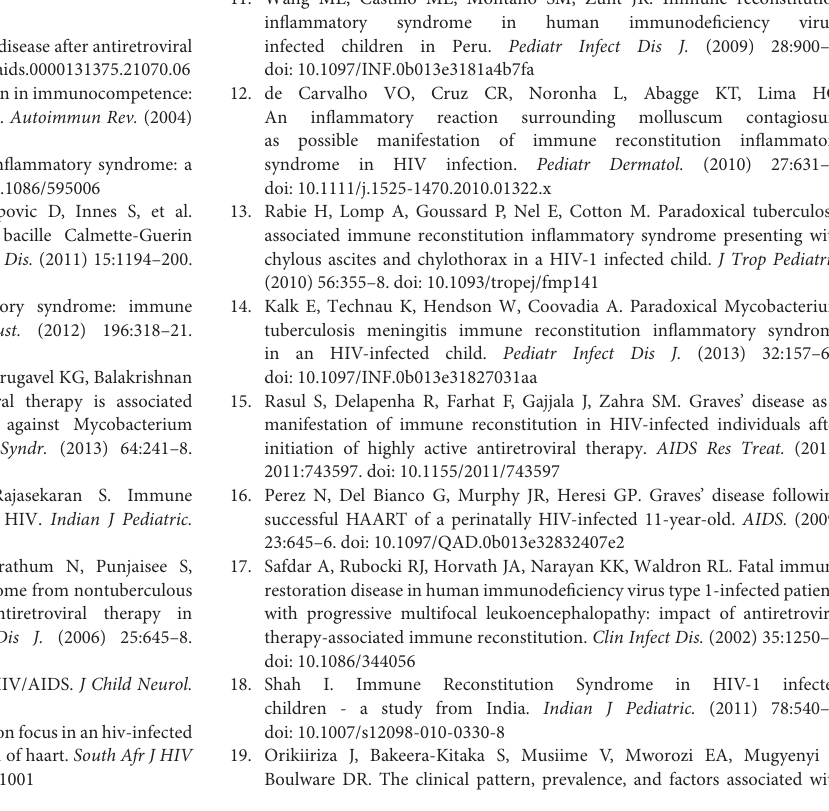
Supplementary Table S1 | Clinical staging, classification, and monitoring characteristics for HIV/AIDS pediatric patients who did not present with IRIS-related infectious events in our